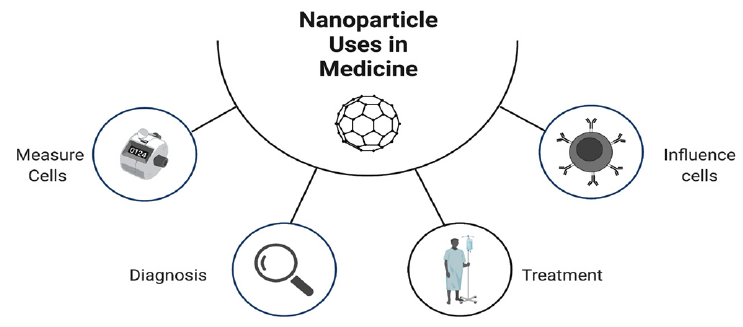
Figure 4. Main uses of nanotechnology in